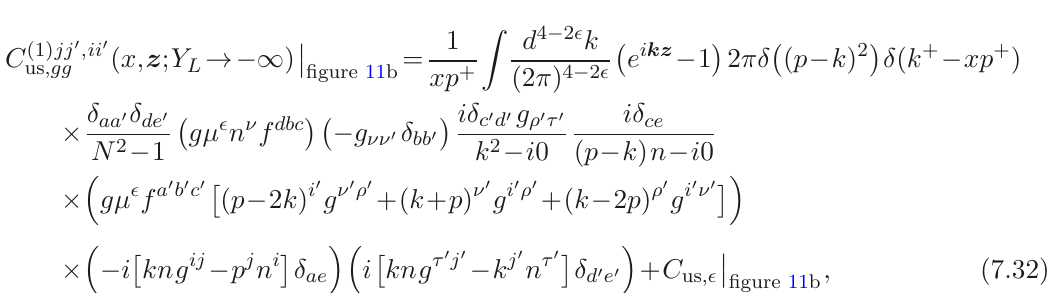
(1) jj ′ ,ii gg (a and b) and M M